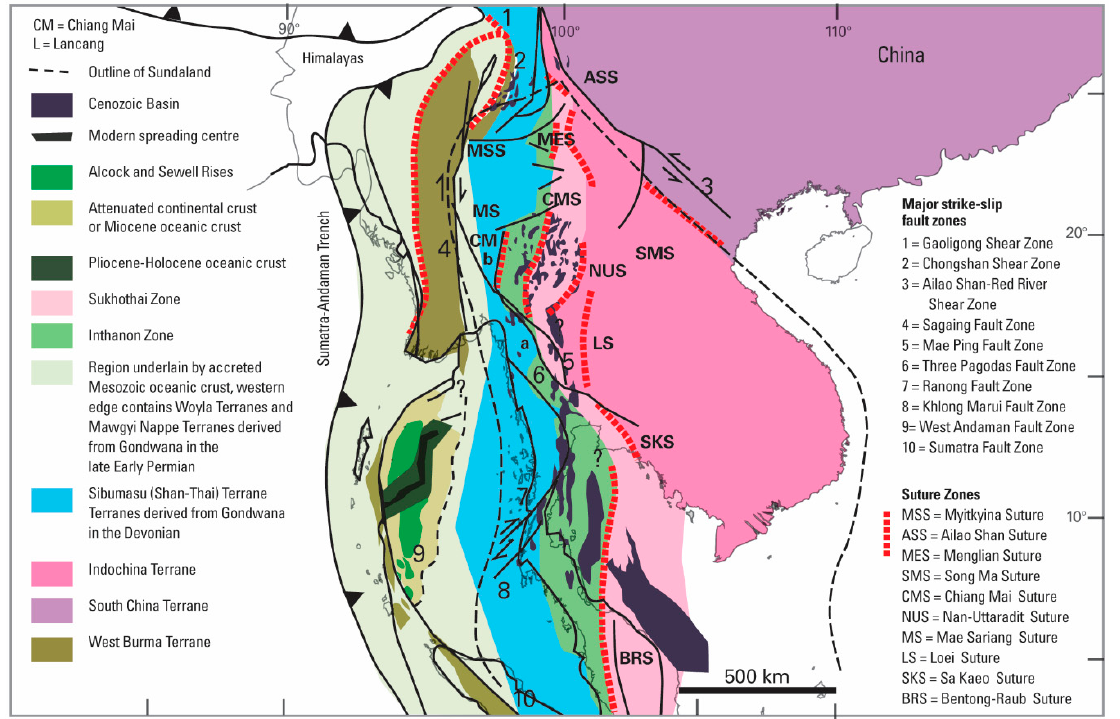
Figure 2. Tectonic map of SE Asia [25]. Cambodia is entirely contained within the Indochina terrain bounded on the northeast by the Song Ma Suture (SMS).